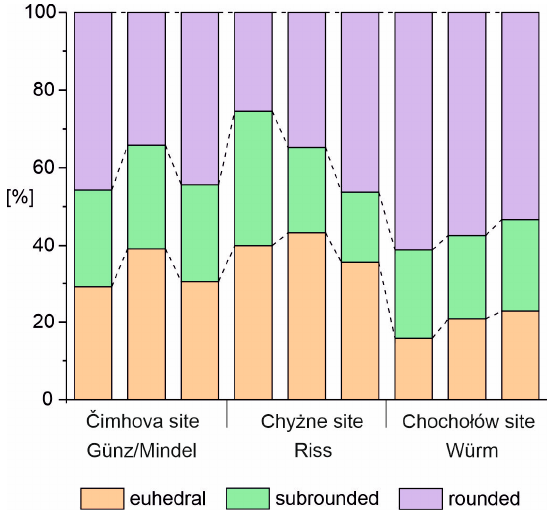
Figure 7. Abundances of morphological types of zircon in the studied deposits from the Orava Basin.